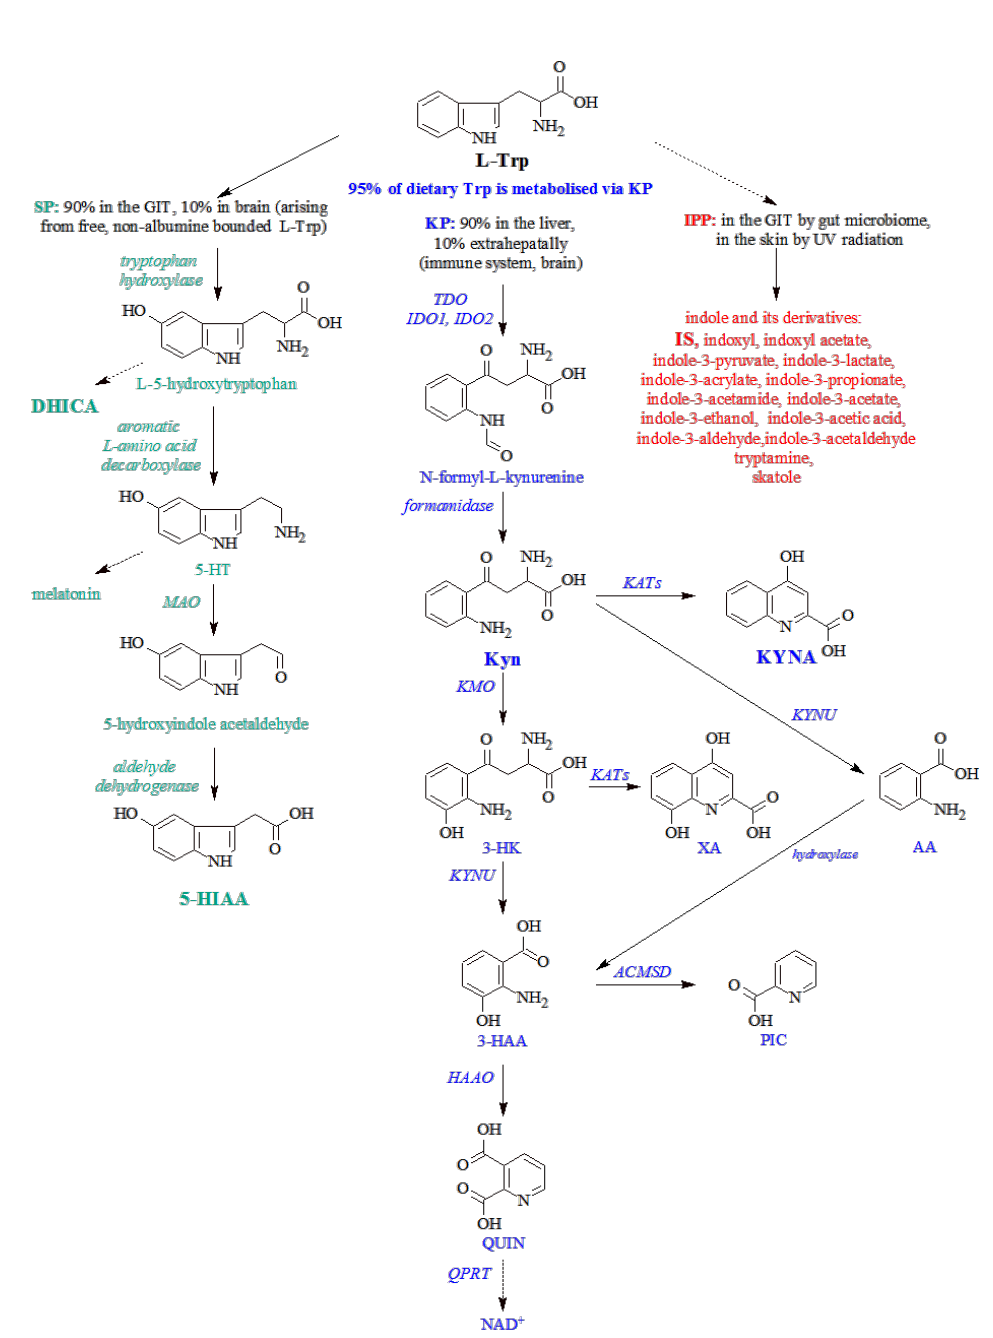
boxylase , MAO— monoaminooxygenase ; dashed arrows include more catalytic reaction steps; metabo- lites analyzed in this study are highlighted in